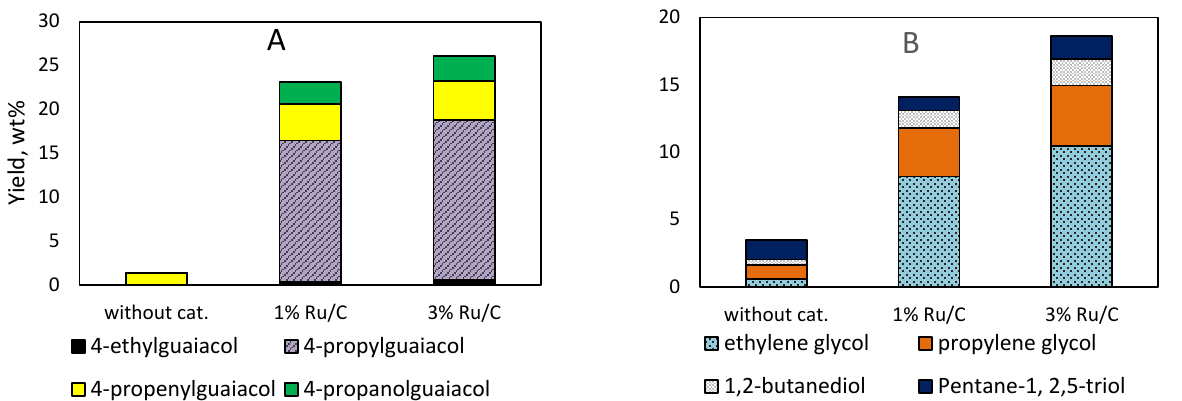
Figure 5. The effect of Ru content in the catalyst on the yield of phenolic monomers ( A ) and polyols ( B ) after spruce wood RCF at 225 °С for 3 h.